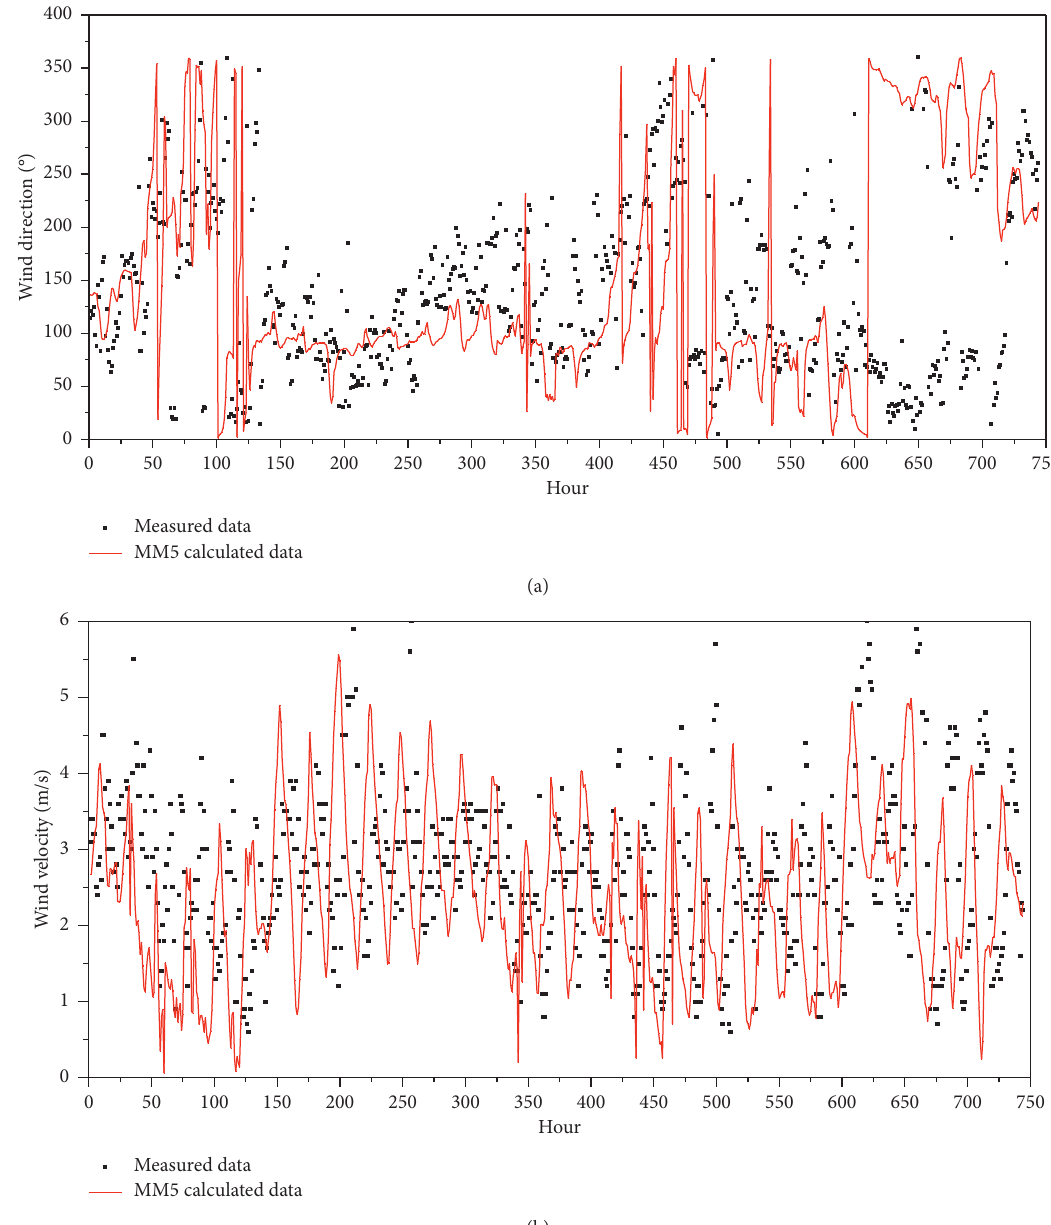
Figure 2: The comparison of measured and calculated meteorological data (Aug.